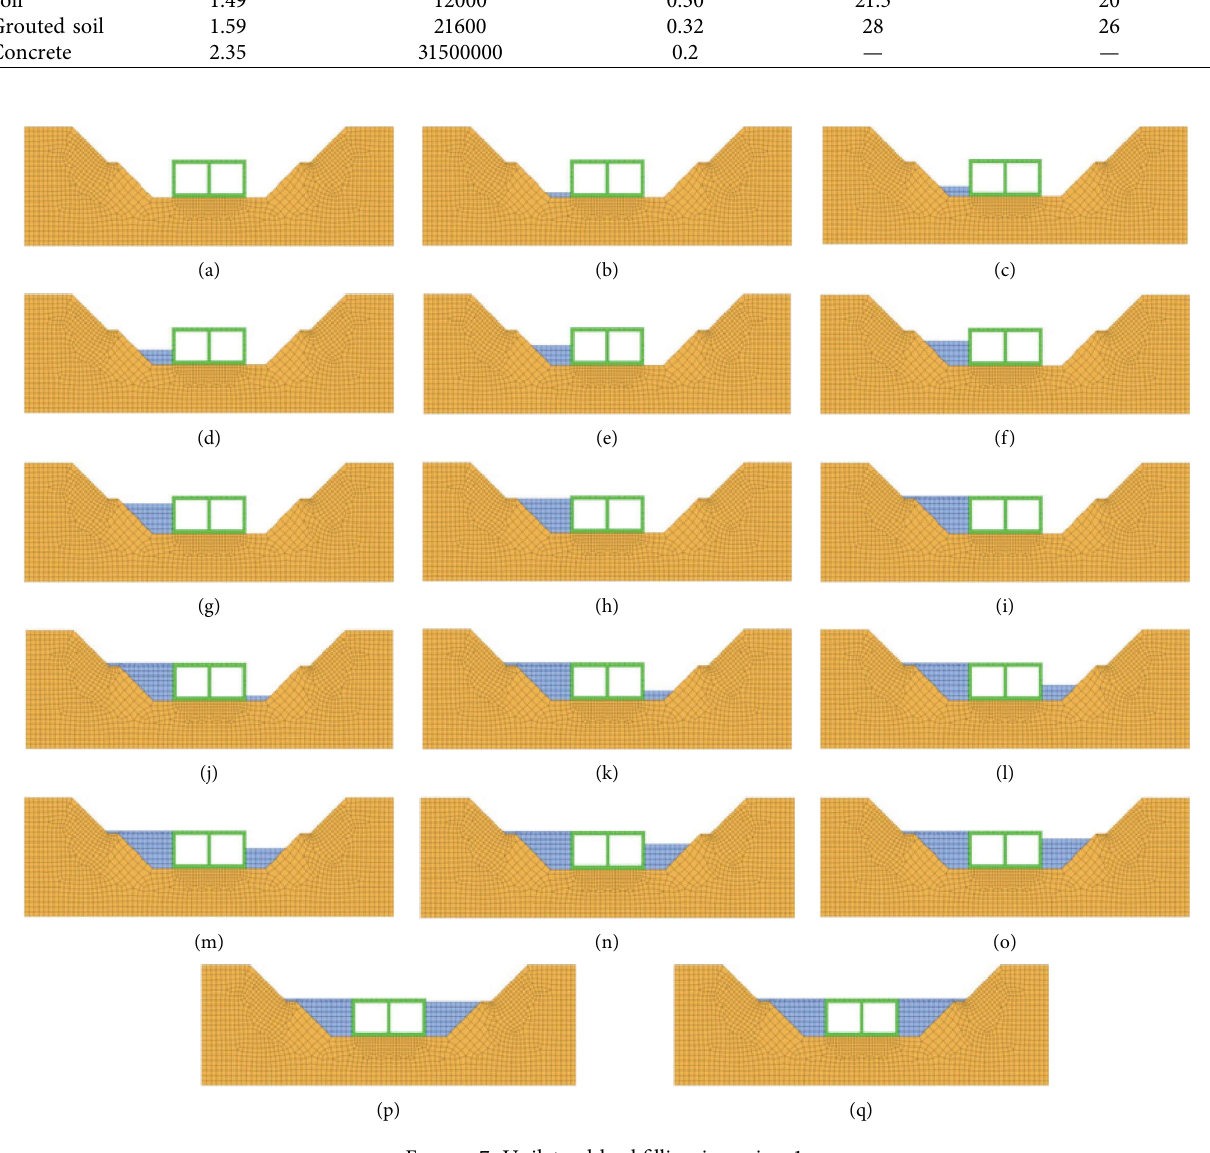
Figure 7: Unilateral backflling in region